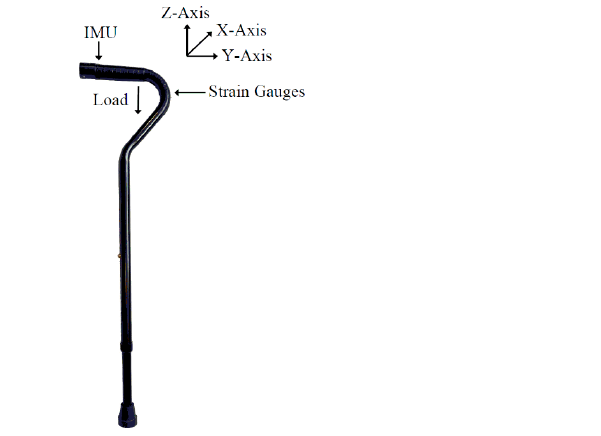
Figure 1. IoT-enabled cane with electronic design implemented within the handle of the cane, as described in [18].